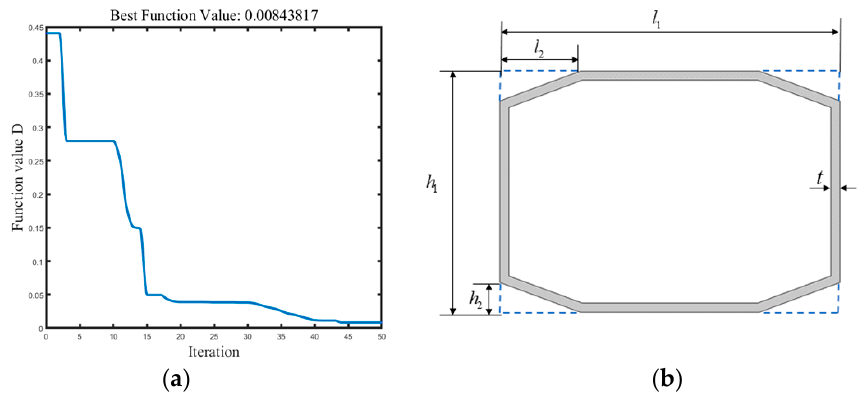
Figure 5. External frame structure optimization: ( a ) particle swarm optimization process; ( b ) optimized post-octagonal frame structural parameters.